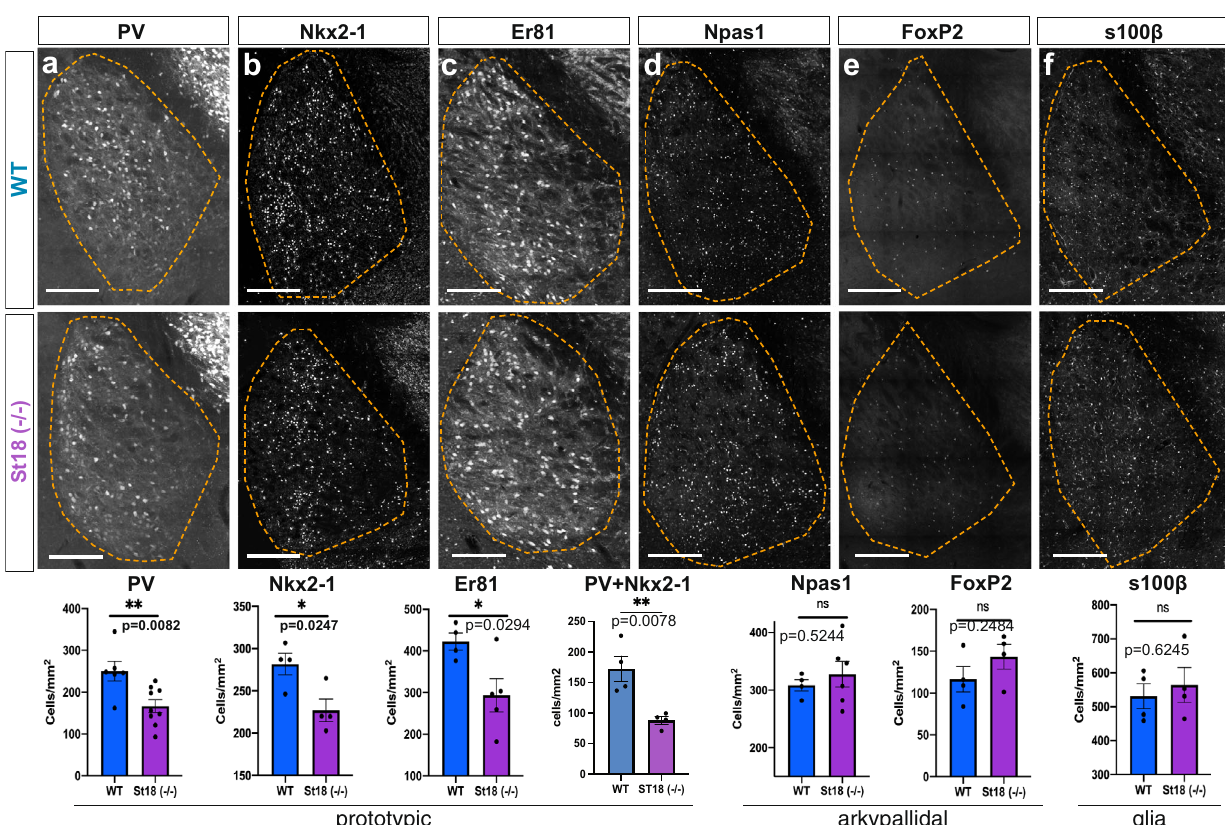
Fig. 4 | Whole animal St18 KO produces a speci fi c loss of MGE lineage GPe projection neurons. a Quanti fi cation of PV+ neurons (Unpaired t-test). N =6 WT and 9 St18 ( − / − ). b Quanti fi cation of Nkx2-1+ neurons (Unpaired t-test). N =4 WT and4 St18 ( − / − ). c Quanti fi cationofEr81+neurons(Unpairedt-test). N =4WTand5 St18 ( − / − ). Quanti fi cation of Nkx2-1/PV double-positive (Unpaired t-test). N =4WT